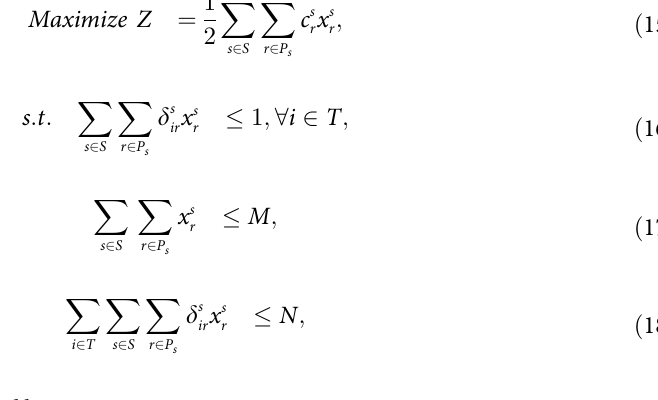
Table 4. Notations for master